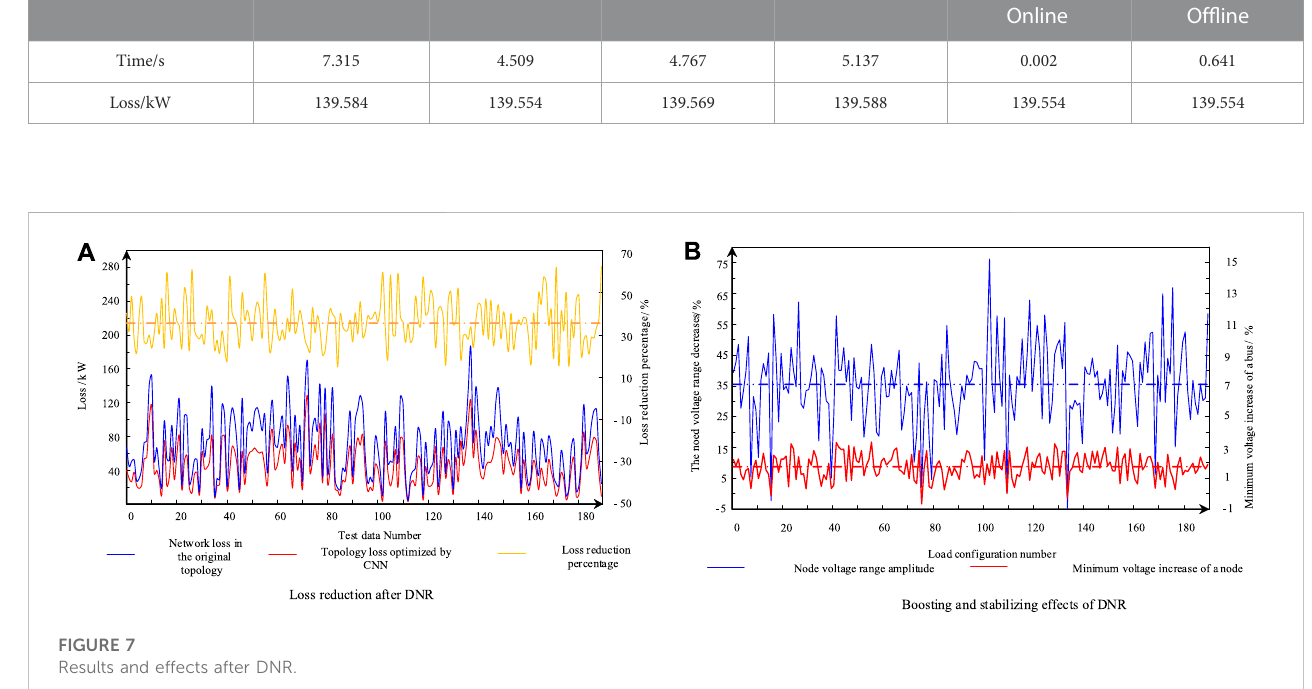
FIGURE 7 Results and effects after